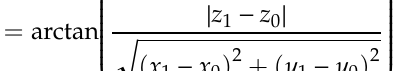
and the method of randomly selecting points and vectors ( c ) and ( d ).